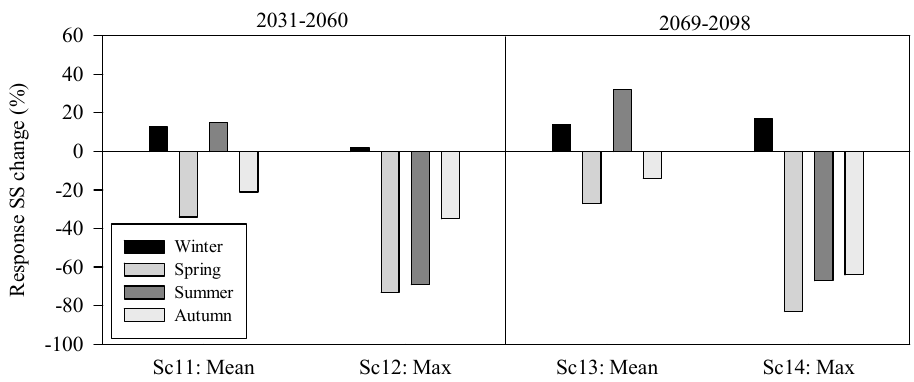
Figure 7. Seasonal response of suspended sediment yield to combined changes in temperature, rainfall and CO 2 concentration based on the scenarios defined in Table 1. Sc11: T + mean 2031–2060 °C, P–mean 2031%–2060%, CO 2 550; Sc12: T + max 2031–2060 °C, P–mean 2031%–2060%, CO 2 550; Sc13: T + mean 2069–2098 °C, P–mean 2069%–2098%, CO 2 660; Sc14: T + max 2069–2098 °C, P–max 2069%–2098%, CO 2 660.